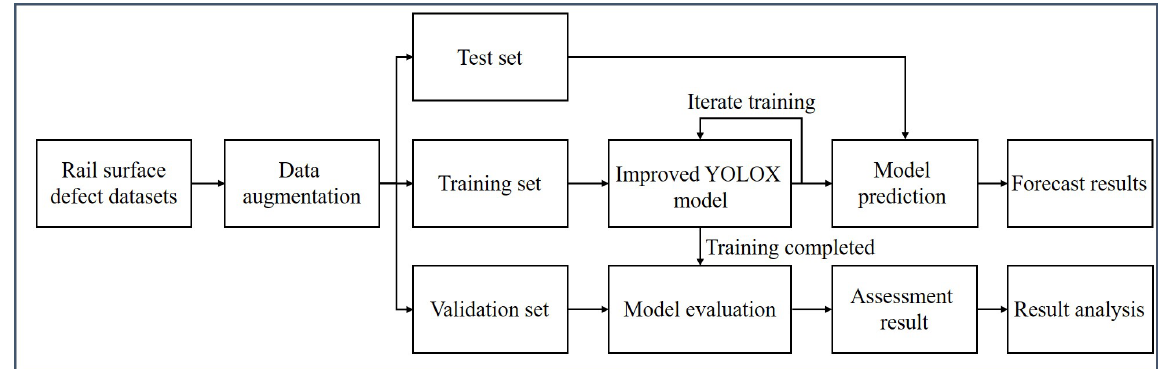
Fig. 8. The flow chart of the proposed